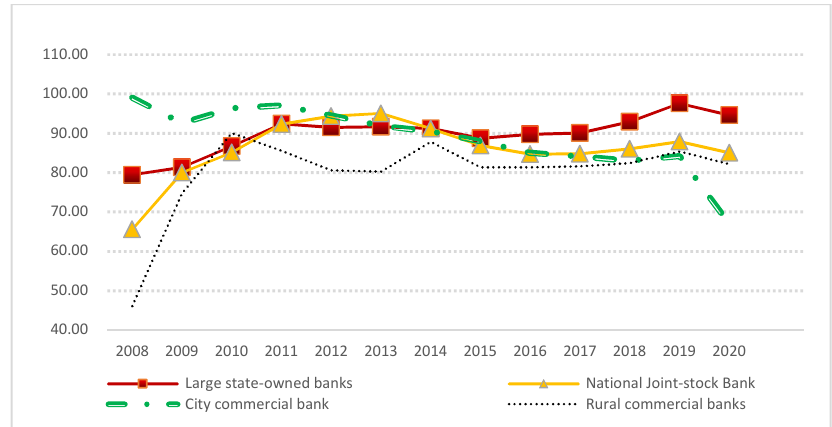
Figure 4. Average operating efficiency and slack variables.